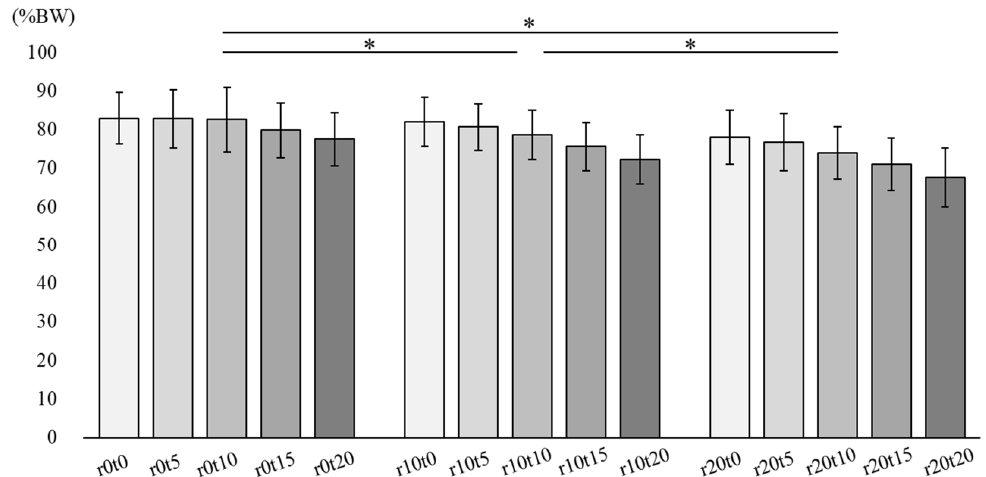
Figure 2. Normal Force. R: reclining, t: tilt-in-space. * There were significant differences of reclining condition in multiple comparisons.